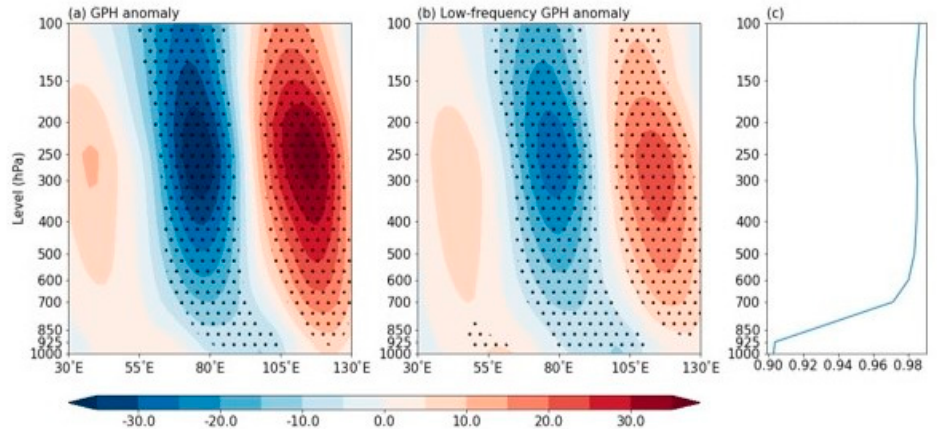
Figure 5. Composited vertical-zonal geopotential height (GPH) ( a ) and its low-frequency (10–30 d oscillation) ( b ) anomalies averaged over 35°–65° N for the onset of LFEHTs in northeast China. ( c ) (Cor.(( a ) and ( b )) is the distribution of their spatial correlation coefficient at every level. Dotted areas are significant at a 95% confidence level.